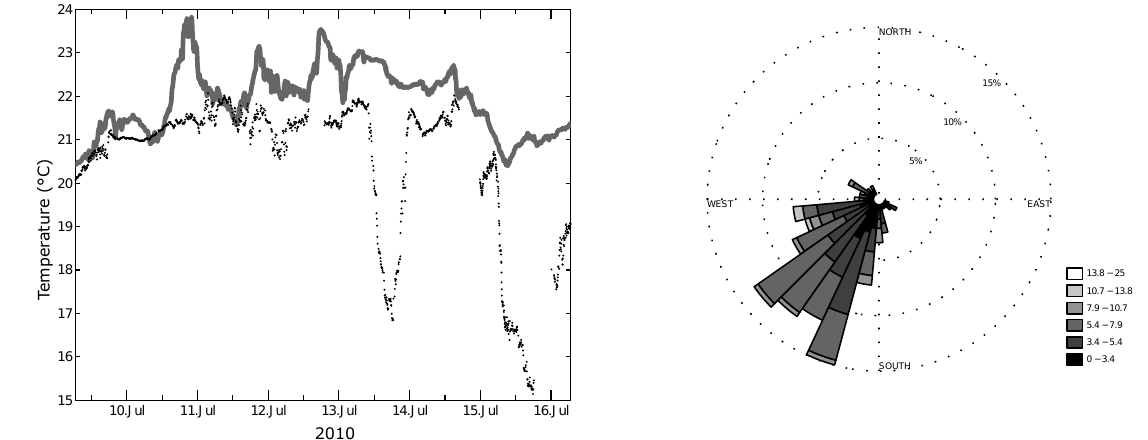
Figure 7. Left: sea surface temperature (at nominal 1m depth) recorded at the Kiel lighthouse (grey line) and glider temperature (black dots) (observation closest to the surface at typically 0.5 to 1m depth). Right: wind rose plot of Schönhagen wind taking into account all data within 12h before an SST difference between Kiel lighthouse and BE survey of larger 2K was detected (considering the period 1988 to 2012).